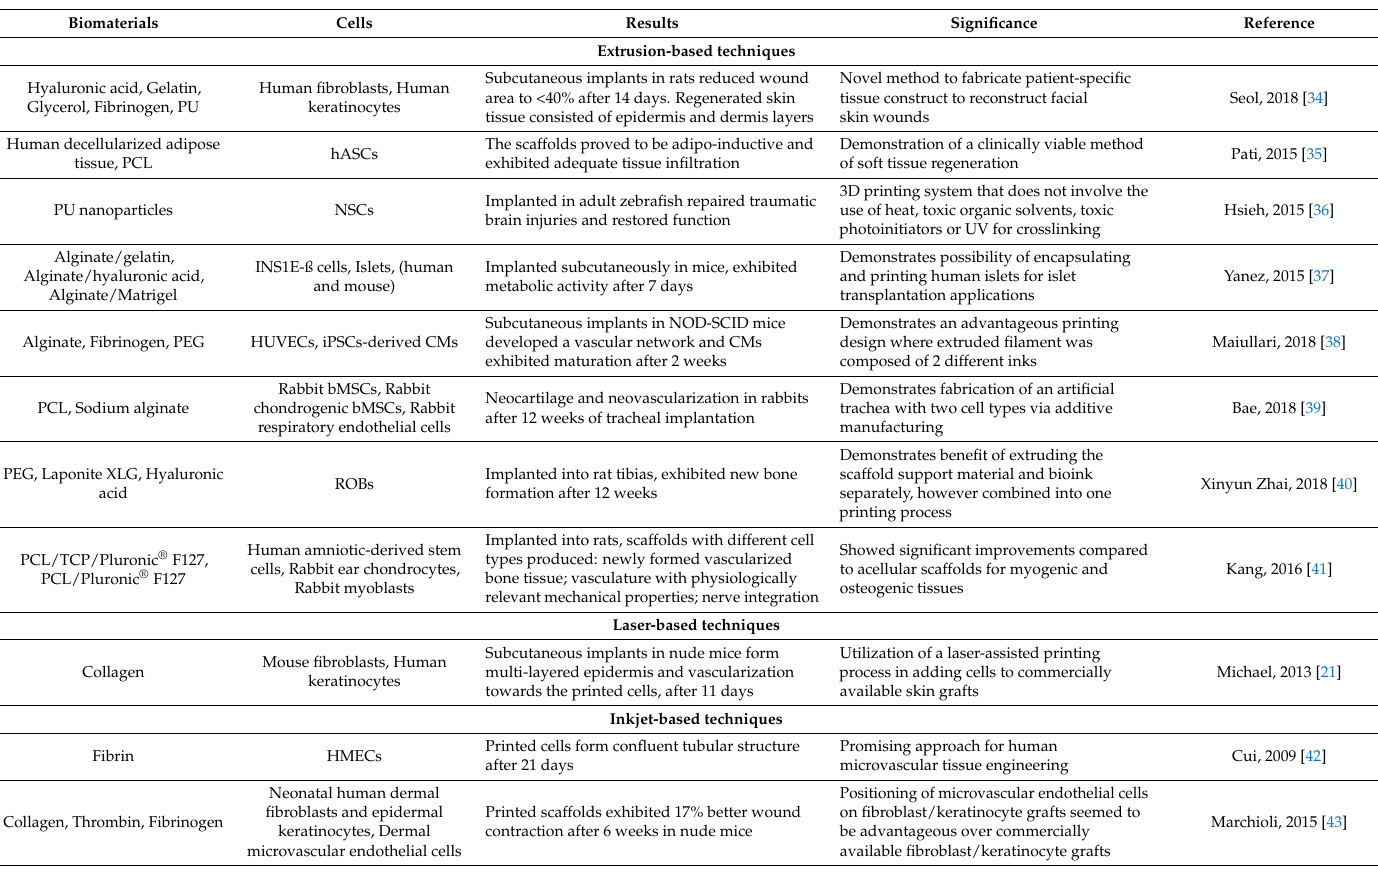
Table 2. Recent in vivo studies. Abbreviations: PU—poly(urethane), PCL—poly(caprolactone), hASCs—human adipose-derived stem cells, NSCs—neural stem cells, PEG—poly(ethylene glycol), HUVECs—human umbilical vein endothelial cells, iPSCs—induced pluripotent stem cells, CM—cardiomyocytes, bMSCs—bone marrow-derived mesenchymal stem cells, ROB—rat osteoblasts, TCP—tricalcium phosphates, HMECs—human microvascular endothelial